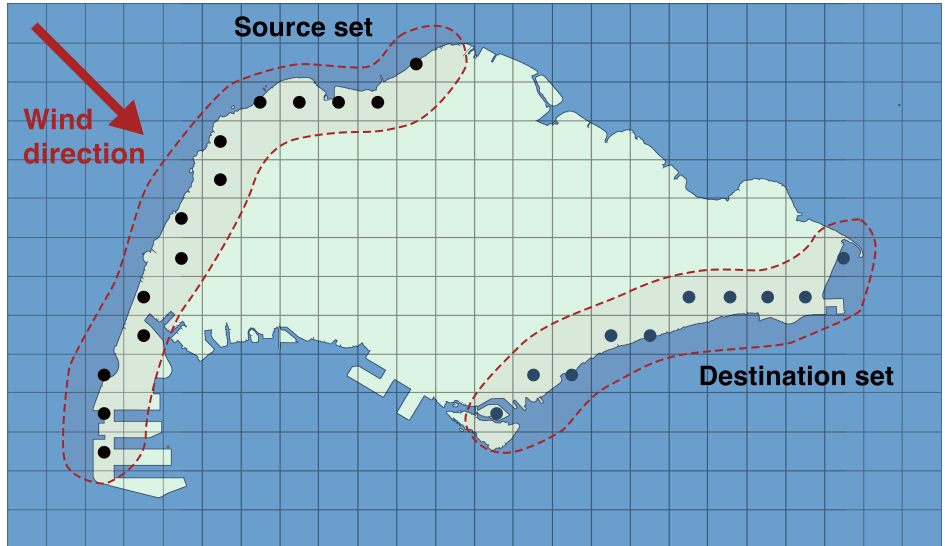
Figure 6. The domain Z is the light green shape, partitioned into a King’s graph structure (black squares), denoted G . The source (black dots) and destination (dark blue dots) sets are indicated for θ A = π /8 by the red